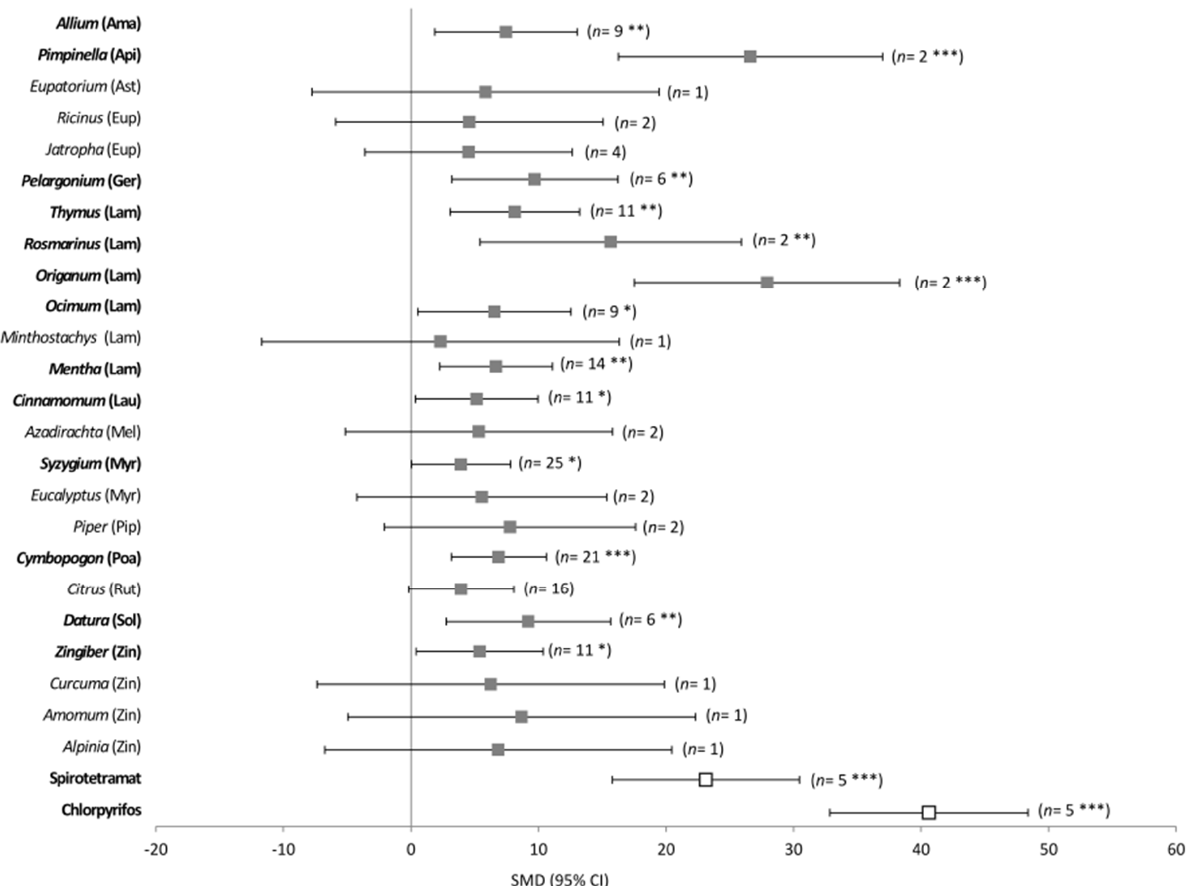
Figure 2. Meta-analysis of the insecticidal effect of EOs against mealybugs of the Pseudococcidae family using plant genera as a moderating variable. Spirotetramat and chlorpyrifos are synthetic insecticides (white squares) used to compare their activity with the EOs ones (black squares). Ab- breviations are as follows: Amaryllidaceae (Ama), Apiaceae (Api), Asteraceae (Ast), Euphorbiaceae (Eup), Lamiaceae (Lam), Lauraceae (Lau), Myrtaceae (Myr), Poaceae (Poa), Rutaceae (Rut), Geraniaceae (Ger), Meliaceae (Mel), Piperaceae (Pip), Solanaceae (Sol), Zingiberaceae (Zin). SMD: standardized mean difference; CI: confidence interval. The EOs from plant genera with significant effects are shown in bold (their mean value is different from zero). *** p <0.001, ** p < 0.01, and * p < 0.05. The EOs of Pimpinella anisum (Apiaceae), Pelargonium graveolens (Geranaceae), Thymus vulgaris (Lamiaceae), Rosmarinus officinalis (Lamiaceae), Ocimum gratissimum (Lamiaceae), Mentha piperita (Lamiaceae), Cinnamomum multiflorum (Lauraceae), Origanum onites (Lami- aceae), Cymbopogon citratus (Poaceae), and Datura alba (Solanaceae) showed insecticidal effect against mealybugs, with P. anisum and O. onites EOs reporting insecticidal activi- ties similar to those of chlorpyrifos and spirotetramat (QM = 118.68, df = 39, p < 0.0001, Figure